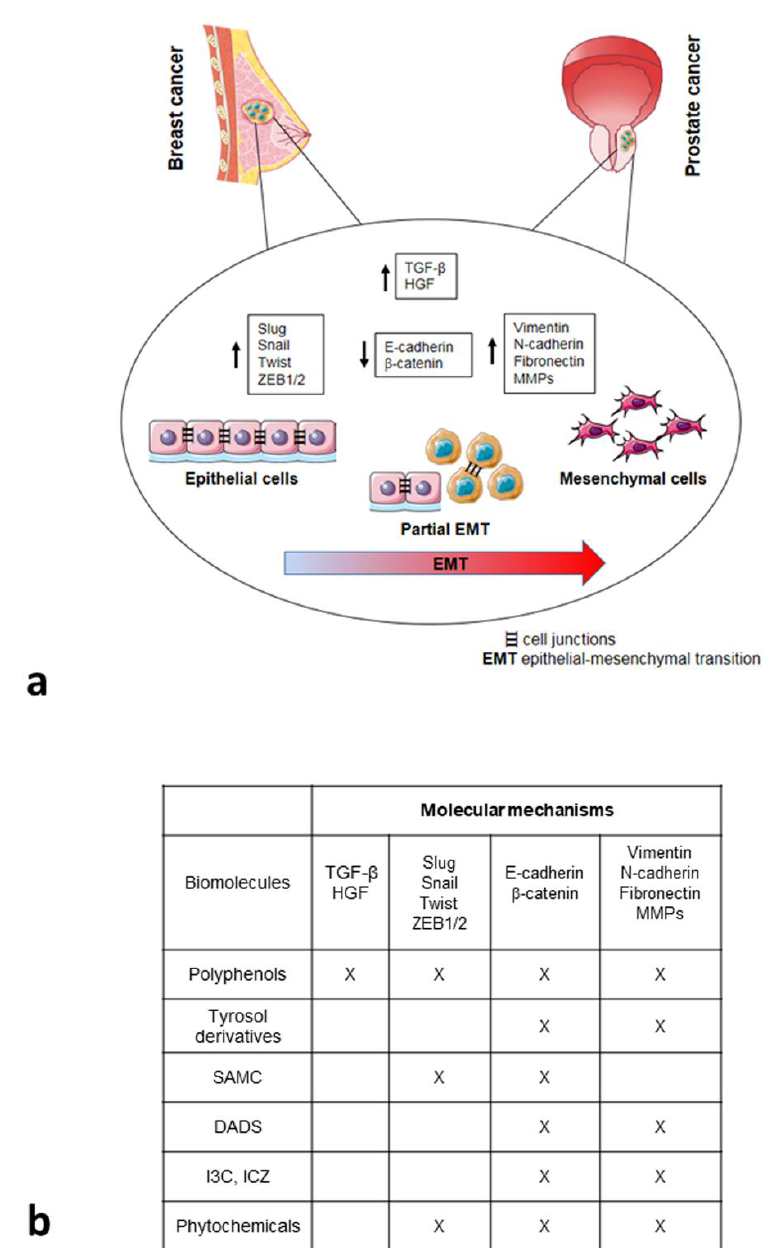
Figure 1. Epithelial-to-mesenchymal transition (EMT) program in breast and prostate cancers and roles exerted by different compounds belonging to Mediterranean diet. ( a ) Molecular processes leading to EMT development. MMPs, metalloproteinases; TGF-β, transforming growth factor beta; HGF, hepatocyte growth factor (figure created using Servier Medical Art available at https://smart.servier.com, accessed on 10 June 2021). ( b ) Bioactive molecules in EMT process grouped for chemical nature and their site of action, which is indicated by “X”.